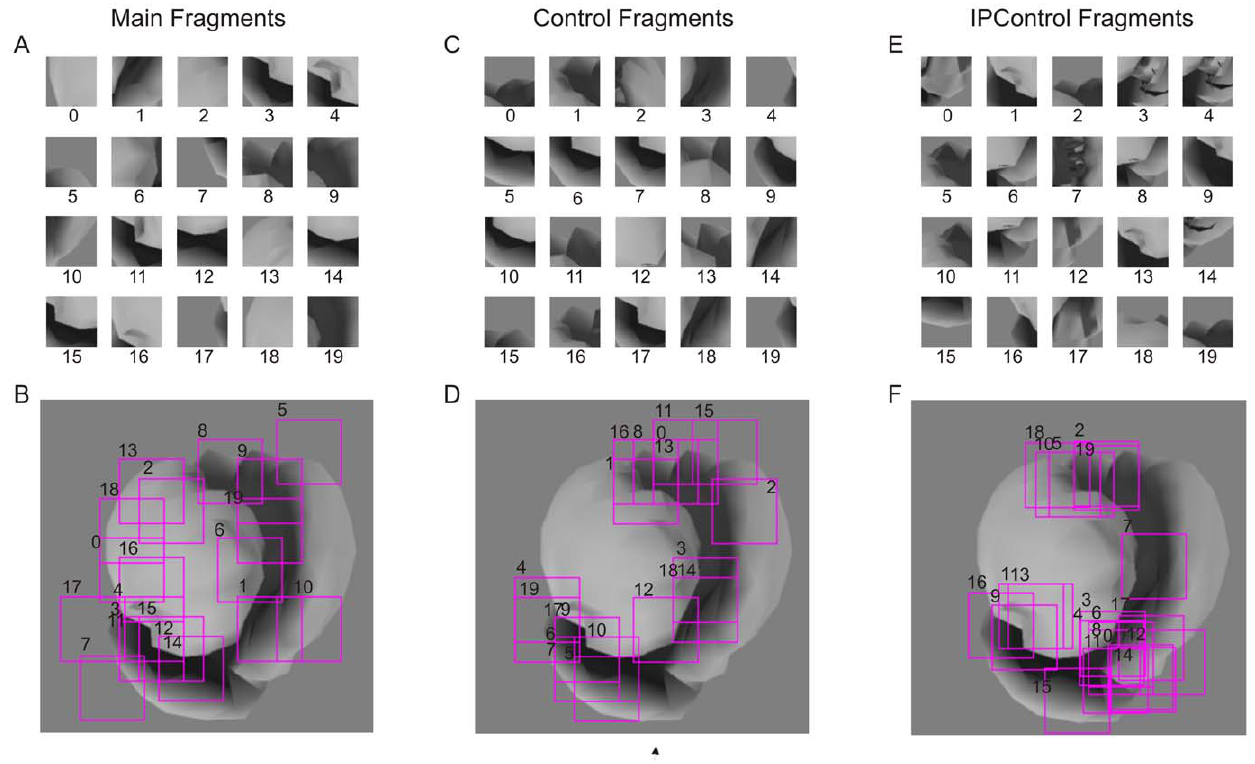
Figure 4. Object fragments used in Experiment 1. ( A ) Main fragments, which are 50 6 50 pixel fragments of objects from class X that are useful for distinguishing class X from class Y (Main task). ( B ) Location of the Main fragments, overlaid on a typical object from class X. Fragment borders are outlined in yellow for clarity. ( C ) Control fragments, which are fragments of objects from class X that are useful for distinguishing class X from class Z (‘Control task’), but are not useful for the Main task. ( D ) Location of the Control fragments. See text for details. ( E ) IPControl fragments, which were uninformative for the Main task, but comparable visually to the Main fragments. ( F ) Location of the IPControl fragments. In panel B, D and F, the fragments are overlaid on a typical object from class X. Note that the fragments were extracted from different images of class X, although they are overlaid together in this figure. Thus, although some of the fragments overlap in this figure, they are usually quite different in their visual content. doi:10.1371/journal.pone.0015444.g004 Table 2). The same two monkeys participated in this experiment.